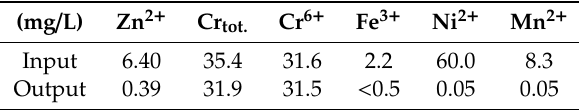
Table 2. Removal of contaminants using only Ca(OH)